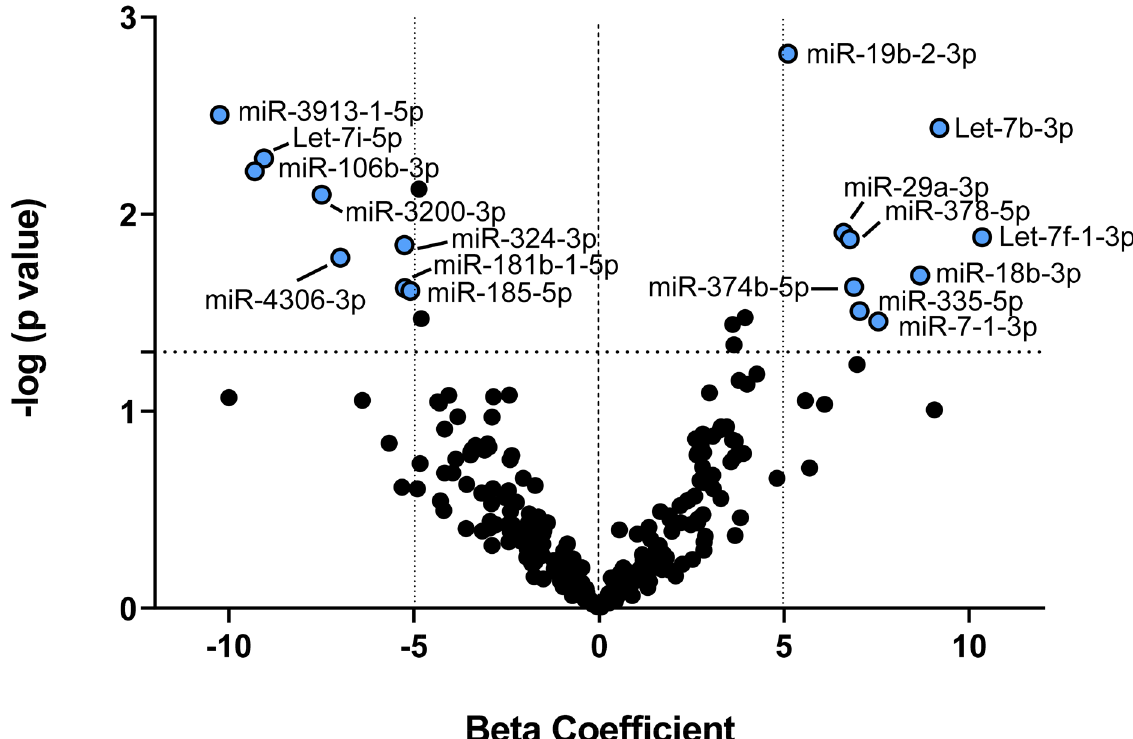
Figure 2. Volcano plot showing microRNA that predict persistent neck pain disability following motor vehicle collision trauma. Statistically significant microRNA were defined as having a p -value below 0.05 (i.e. those above the horizontal dotted line) and a magnitude of effect above and below a beta coefficient of ± 5 (i.e. to the left and right of the vertical dotted lines). Statistically significant microRNA are labeled and colored blue.